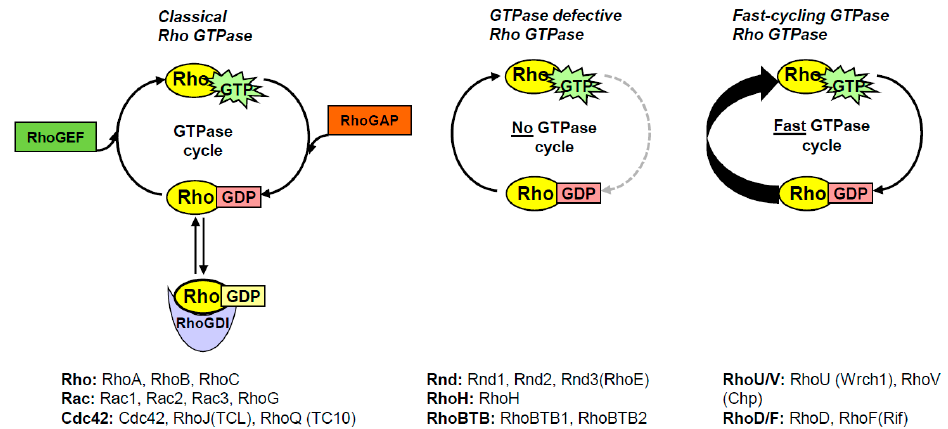
Figure 1. Schematic representation of the GTPase cycling of the different Rho GTPases. The classical Rho GTPases cycle between their GDP-bound and GTP-bound conformations, which is governed by RhoGDIs, RhoGEFs, and RhoGAPs. The Rho GTPases that belong to the respective categories are indicated below each